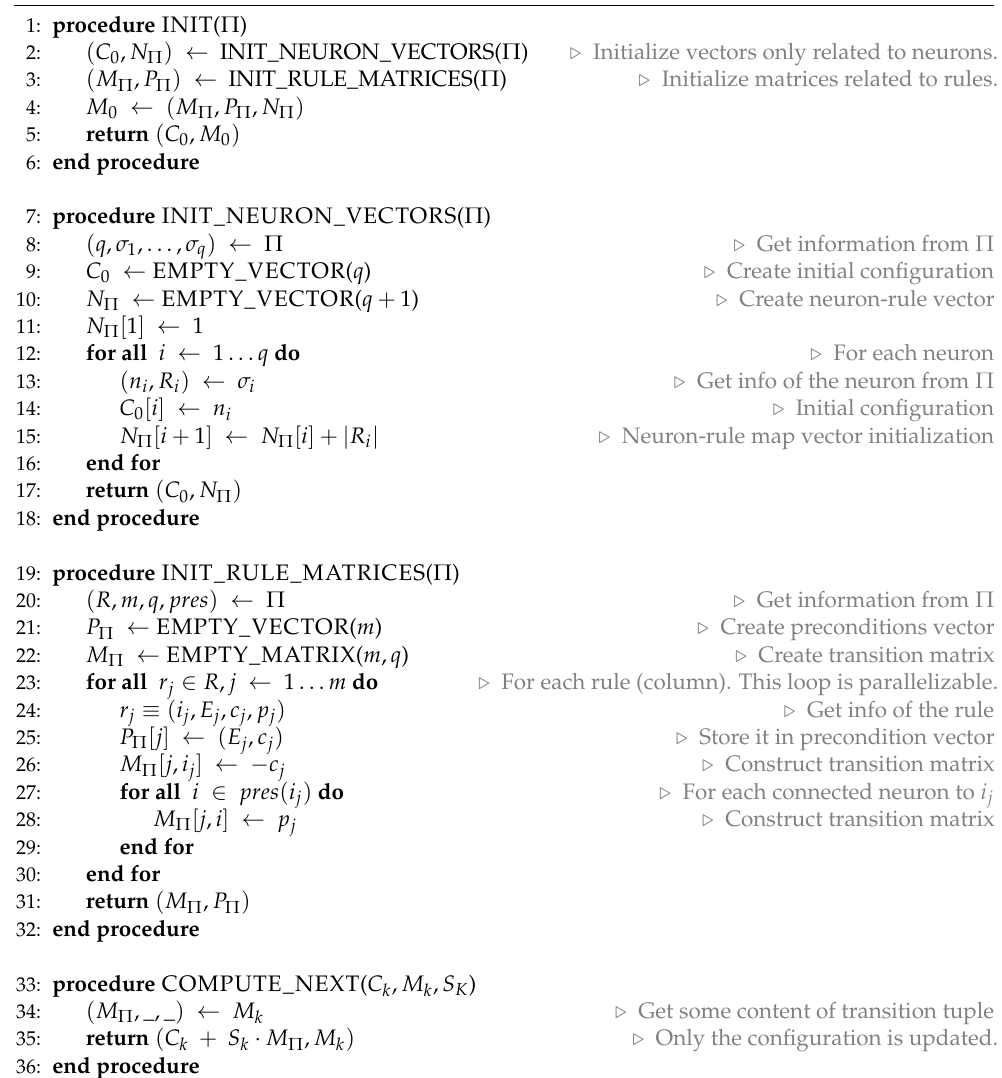
Algorithm 3 Functions for static SNP systems with sparse matrix